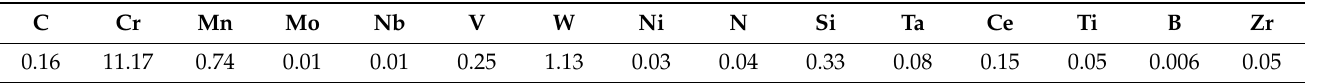
Table 1. Elemental composition of EK-181 steel (wt.%, base